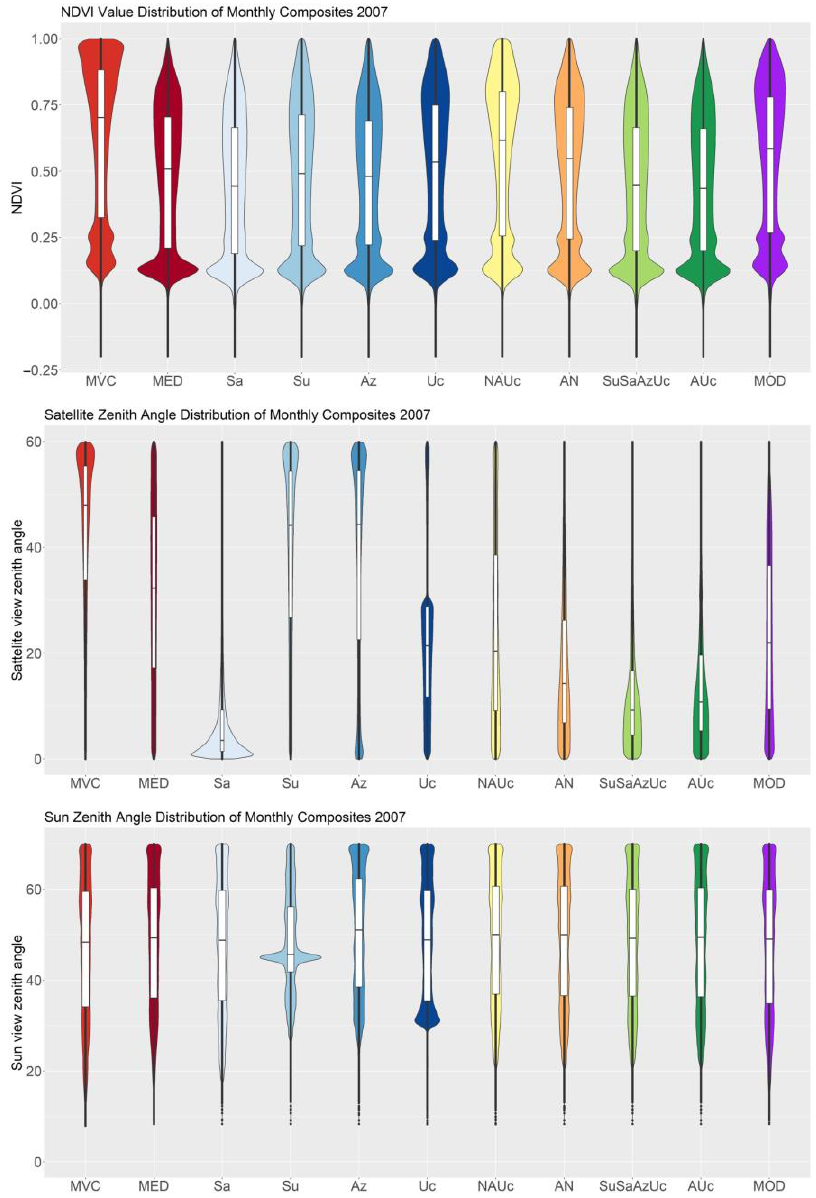
Figure 4. Violin plots of NDVI ( top ), satellite zenith ( middle ), and sun zenith angles ( bottom ) distributions of each variant, including samples (n = 100,000 per map) from all monthly composites.